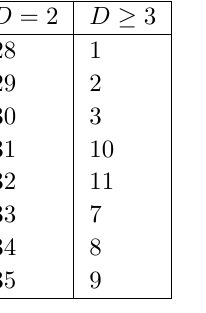
Table 10 . Correspondence between D = 2 and D (cid:21) 3 Lie